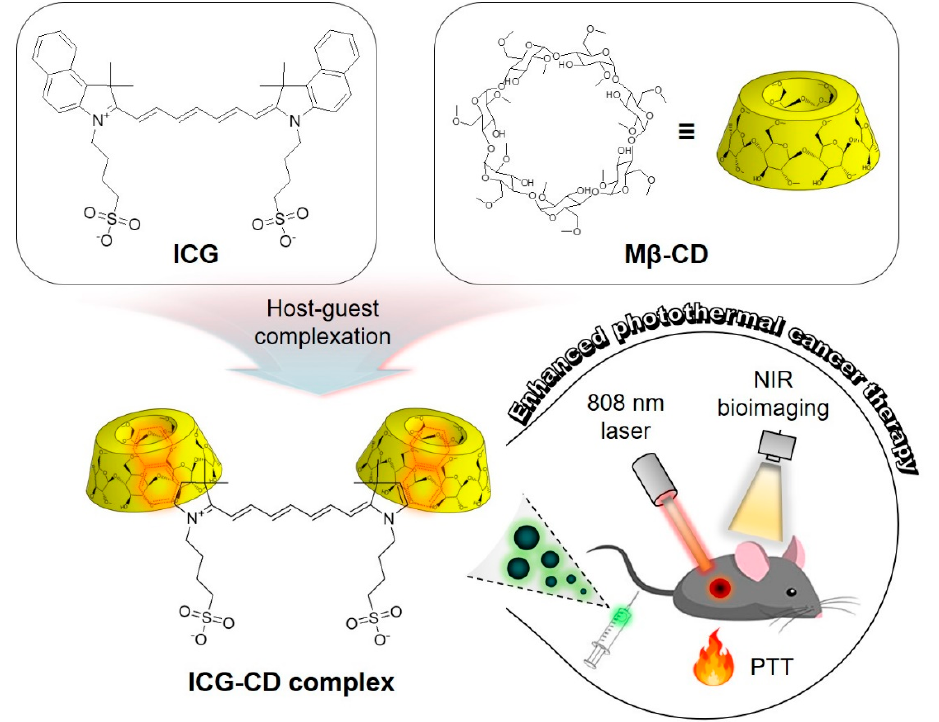
Figure 1. Schematic representation of inclusion complex formation between indocyanine green (ICG) and methyl- β -cyclodextrin (M β -CD) in an aqueous state for enhanced photothermal cancer therapy. PTT: photothermal therapy.